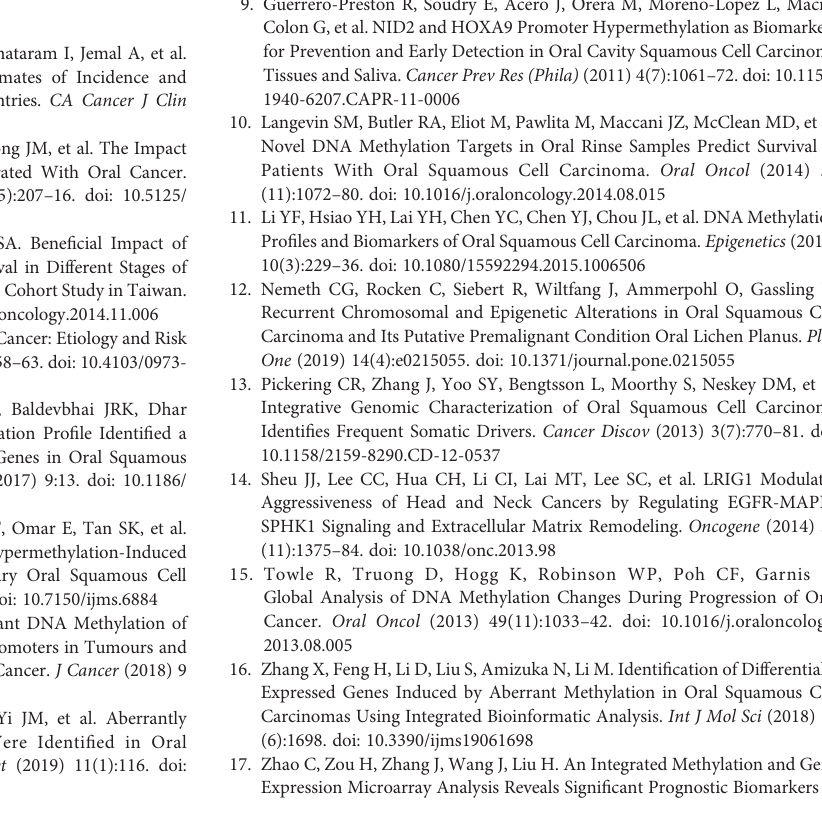
Supplementary Figure 1 | Immune in fi ltration estimation of tissue samples analyzed in this study. Immune in fi ltration of B cell (A) , CD4 + T cell (B) , CD8 + T cell (C) , Neutrophil (D) , Macrophage (E) , and Myeloid dendritic cell (F) were evaluated using TIMER2.0 web server. TCGA-HNSC samples and paired NATs were obtained from TCGA-HNSC project. NAT: Normal Adjacent Tissue. Statistical difference was evaluated using Student ’ s t test with Welch correction. * p < 0.05, ** p < 0.01, *** p < 0.001, **** p <